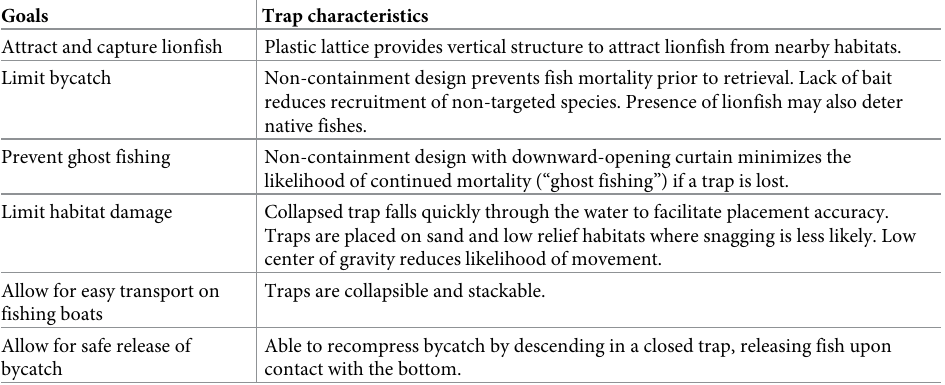
Table 1. Goals of the Gittings lionfish trap with design attributes employed to achieve those goals.